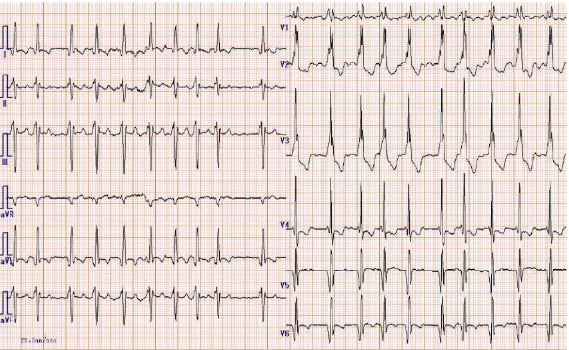
Figure 1: The 12 lead electrocardiograms on admission showing atrial fibrillation with rapid ventricular response and complete right bundle branch